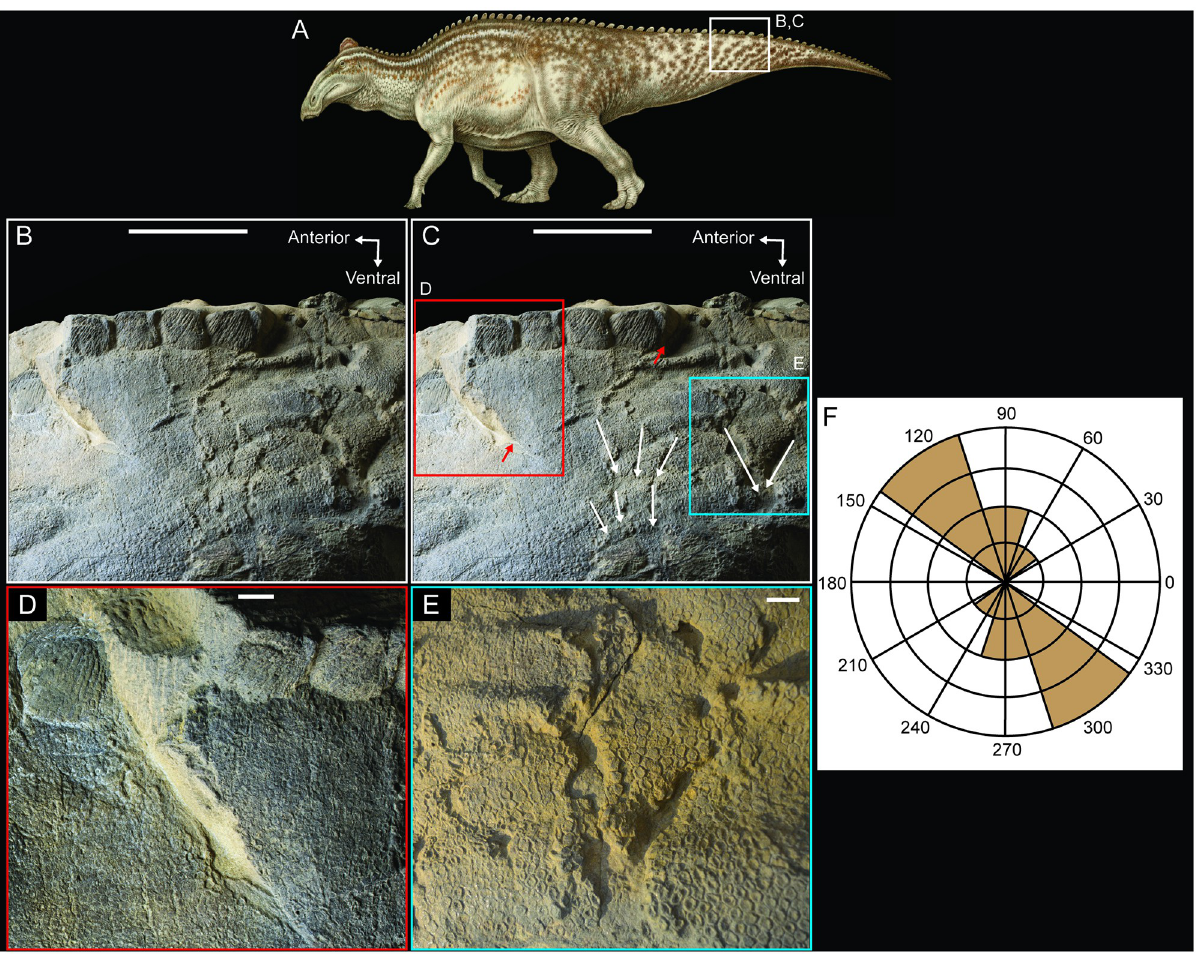
Fig 8. Soft tissue damage on the tail of NDGS 2000. (A) NDGS 2000 reconstruction in left lateral view showing the positions of the close-ups in B-E. (B) Close-up of the dorsal portion of the left lateral surface of the mid-caudal region of the tail providing an overview of the soft tissue injuries in this area. (C) Same view as in B, but with sets of furrows traced with white arrows, tears in the skin denoted with red arrows, and red and blue boxes indicating the positions of the close-up views shown in D and E, respectively. (D) Close-up view of posteroventrally oriented tear in the skin. (E) Close- up of one set of two furrows in the skin that converge ventrally, forming a ‘V-shaped’ tear in the skin. (F) Rose diagram of the orientations of the furrows in the left lateral surface of the tail measured relative to the dorsal margin of the tail. Zero degrees is positioned towards the distal end of the tail. Paleoart in (A) by Natee Puttapipat. Scale bars are 10 cm in B and C, and 1 cm in D and E.